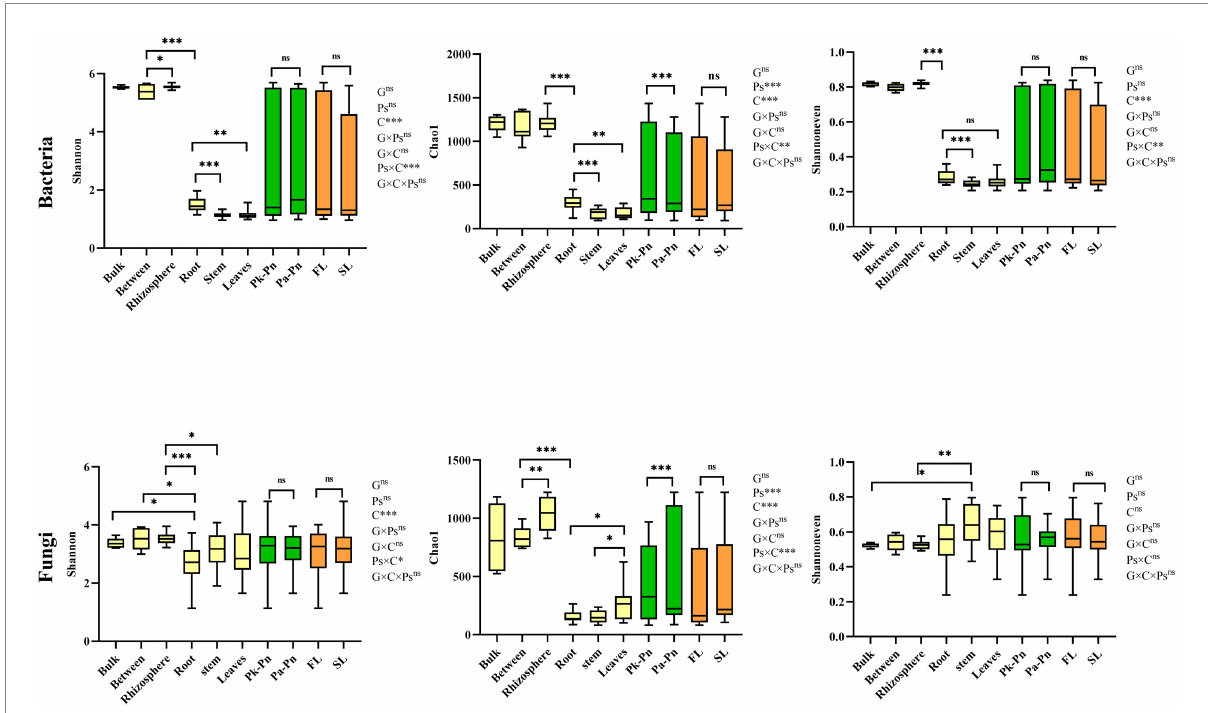
FIGURE 4 Boxplots of indices of bacterial and fungal alpha diversity of microbes in samples from different compartments (bulk, between, rhizosphere soils, and roots, stems, leaves of P.n. ), genotype and pine trees species. Different letters showed significant difference (p < 0.05). The Significance of effects of genotype (G), compartment (C) and pine trees species (Ps) and their interactions on microbial diversity was evaluated by multiway ANOVA. * , p < 0.0 5, ** , p < 0.01, *** , p < 0.001, ns, no